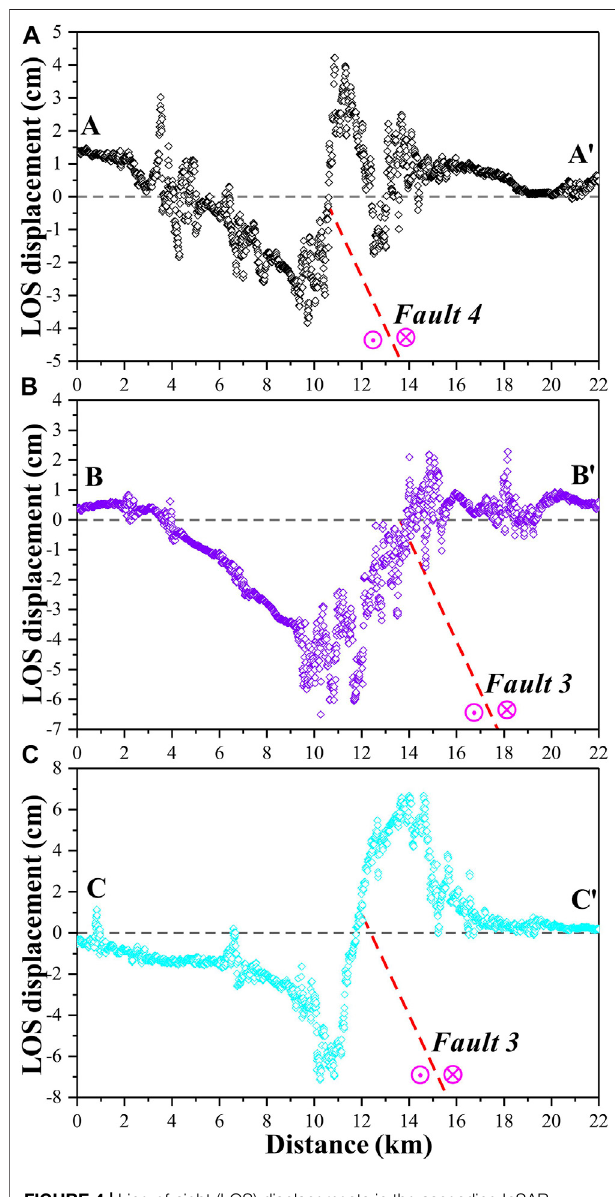
FIGURE 4 | Line-of-sight (LOS) displacements in the ascending InSAR measurements along multiple pro fi les. (A) LOS displacements along Pro fi le A – A ′ . (B) LOS displacements along Pro fi le B – B ′ . (C) LOS displacements along Pro fi le C – C ′ . The locations of Pro fi les A – A ′ , B – B ′ , and C – C ′ are shown in Figure 3